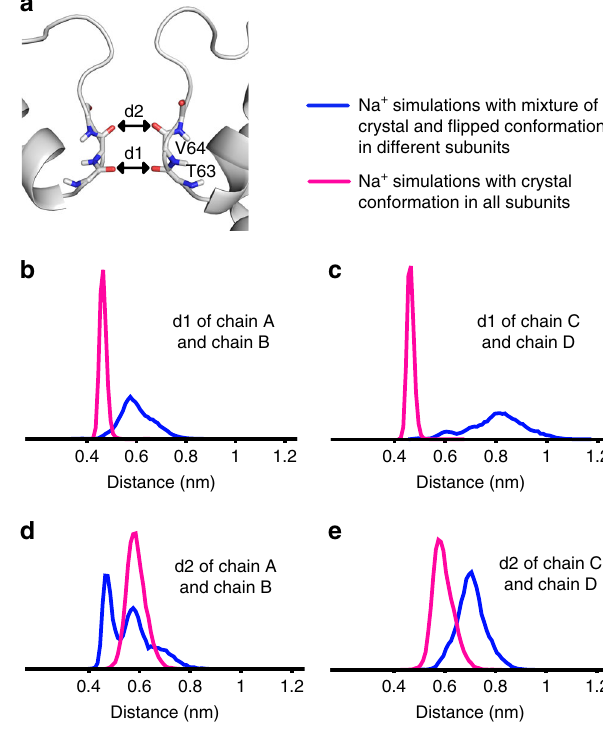
Fig. 5 Distribution of the distance between opposing carbonyls from the MD simulations. a Distance between two T63 residues is indicated with d1 and between two V64 residues with d2. b d1 (T63) of chains A and B, c d1 (T63) of chains C and D, d d2 (V64) of chains A and B, e d2 (V64) of chains C and D. Distances are calculated for the Na + simulations with a mixture of fl ipped and crystal conformations in different subunits (blue curve, simulation V, Supplementary Table 1), and Na + simulations with the crystal conformation in all subunits (magenta curve, simulation